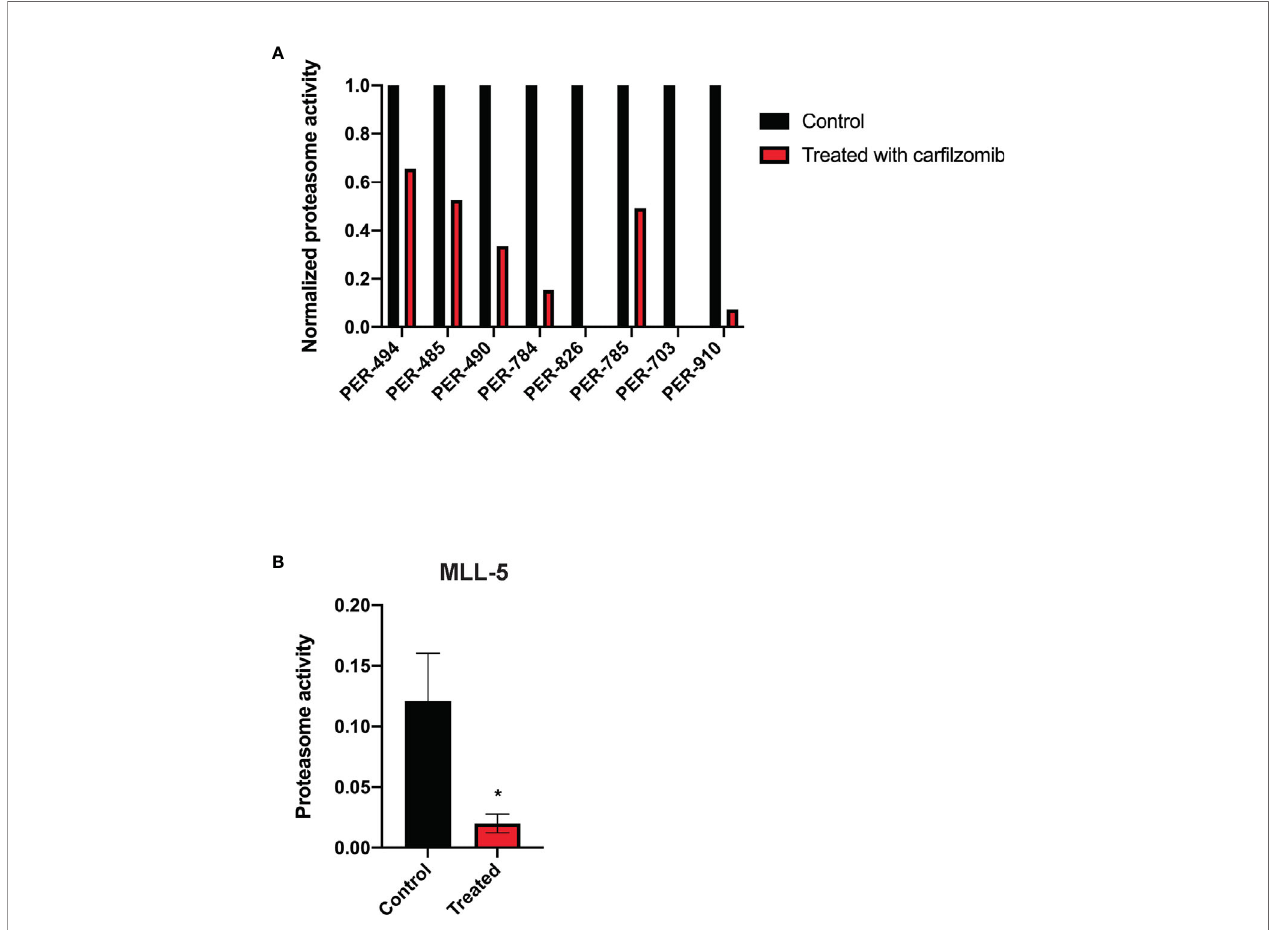
FIGURE 2 | Car fi lzomibinhibitsproteasomeactivity. (A) ProteasomeactivityofPERcelllinesderivedfrominfantswith KMT2A -rearrangedacutelymphoblasticleukemiafollowing incubationwithcar fi lzomibattheirrespectivehalfmaximuminhibitoryconcentrations(IC 50 )for72hnormalizedtoproteasomeactivityofuntreatedcelllines. (B) Proteasomeactivityin peripheralbloodofMLL-5patient-derivedxenograftstreatedwith1.5mg/kgofintravenouscar fi lzomib via tailveininjectionondays1and2comparedtountreatedmice(n=5mice pergroup).Proteasomeactivitywasmeasured10minaftertheinjectiononday2.Miceweretreatedathighleukemicburdeninthebonemarrowcorrespondingtoameanperipheral